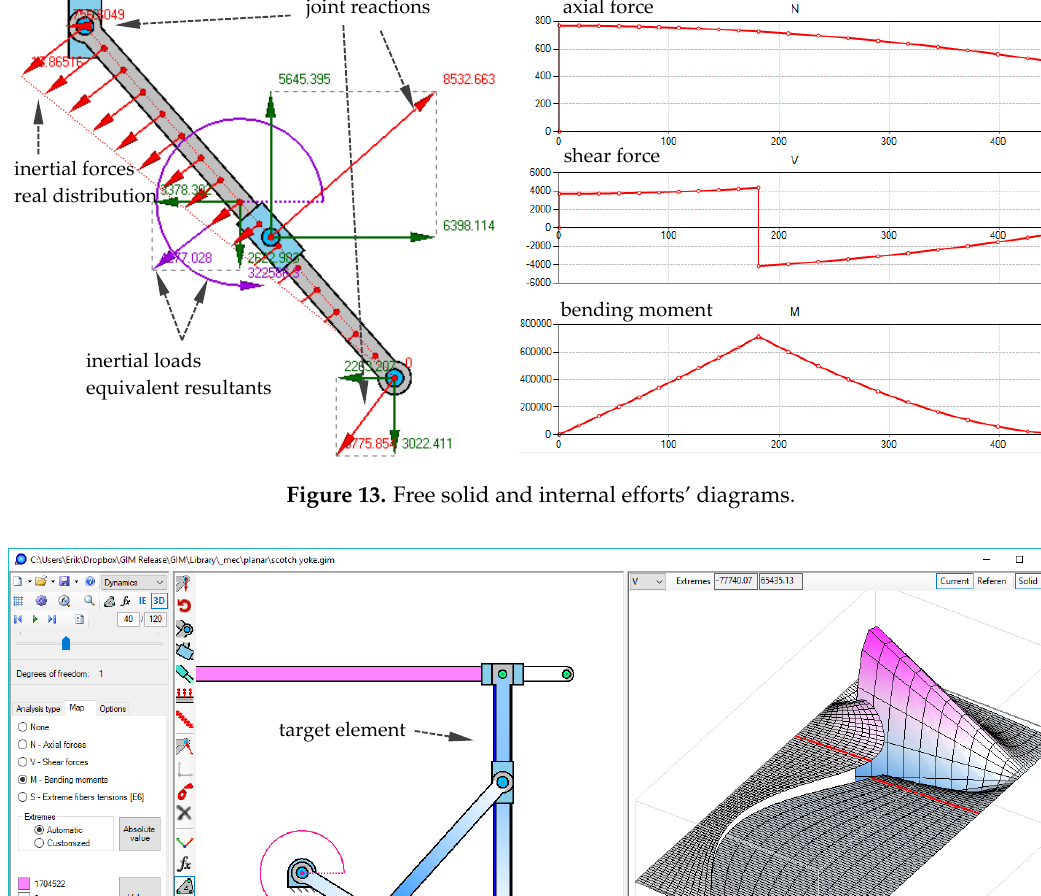
Figure 14. Color map of internal effort for all systems and evolution over time for an